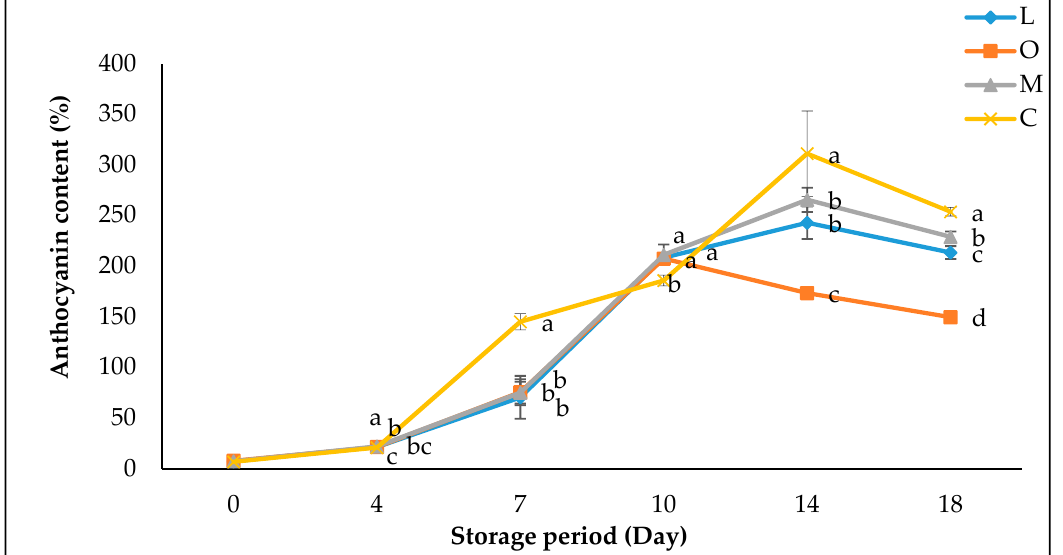
Figure 8. Effect of different essential oil emulsions (L = lemon, O = orange, and M = mandarin essential oil) on anthocyanin content of strawberry fruits stored at 2 °C for 18 days. Vertical bars indicate the standard deviation (n = 6). Means and different letters indicate significant difference between treated and control fruits at each storage period (Duncan’s of 95%).